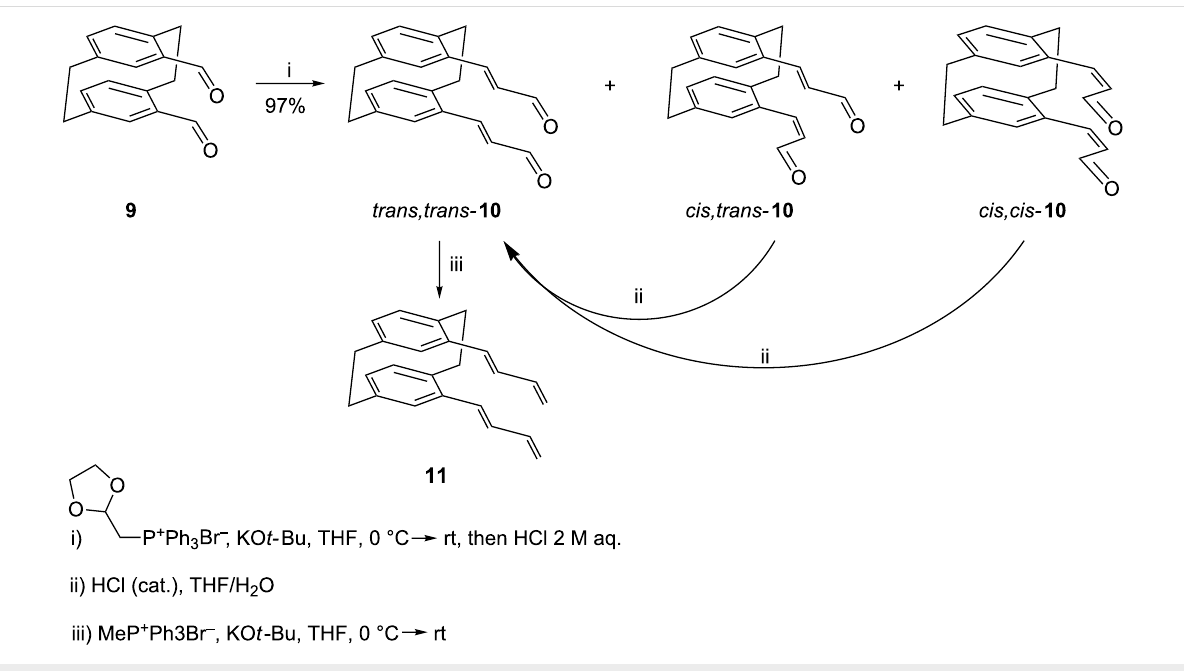
Scheme 4: Preparation of tetraene 11 .